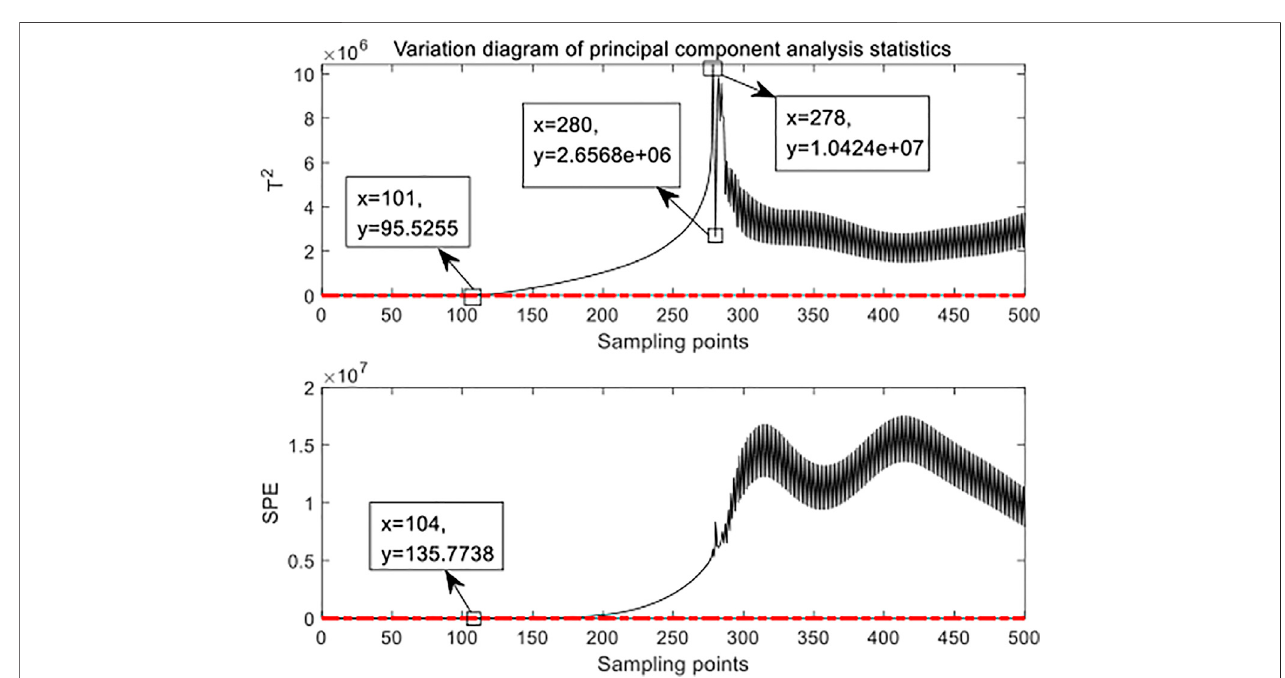
FIGURE 7 | T 2 and SPE indices of case 2.